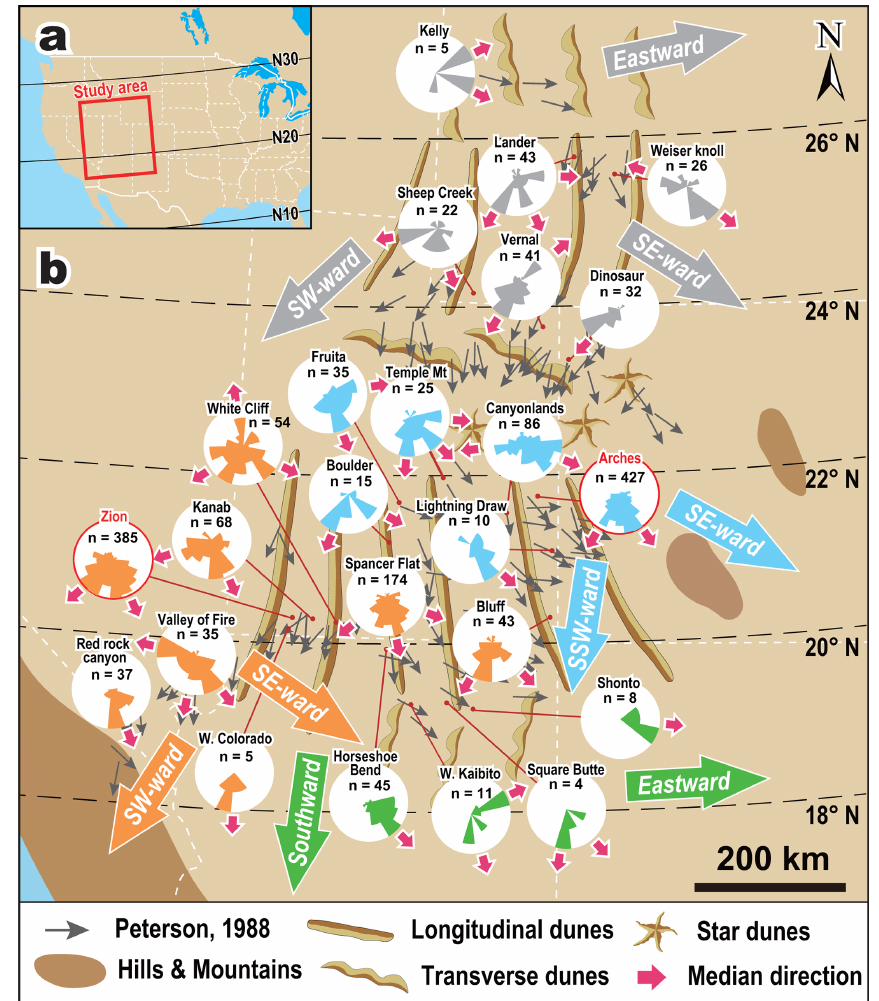
Figure 1. Reconstructed palaeowind patterns in the western US during the Early Jurassic. (a) Location of the study area in the western US. (b) Spatial distributions of dune slip-face azimuths measured in this study (shown on rose diagrams) and inferred dune morphologies plotted on the Early Jurassic palaeogeographic map of Peterson (1988), with palaeolatitudes based on Dickinson (2018). The colours of the rose diagrams indicate the area: northern (grey), central (light blue), southwestern (orange), and southern (green) parts of the study area. Large arrows in (b) indicate the reconstructed prevailing surface wind directions in each area. The pink arrows around the outside of each rose diagram indicate the median directions of separated components in the slip-face azimuth data provided in Table